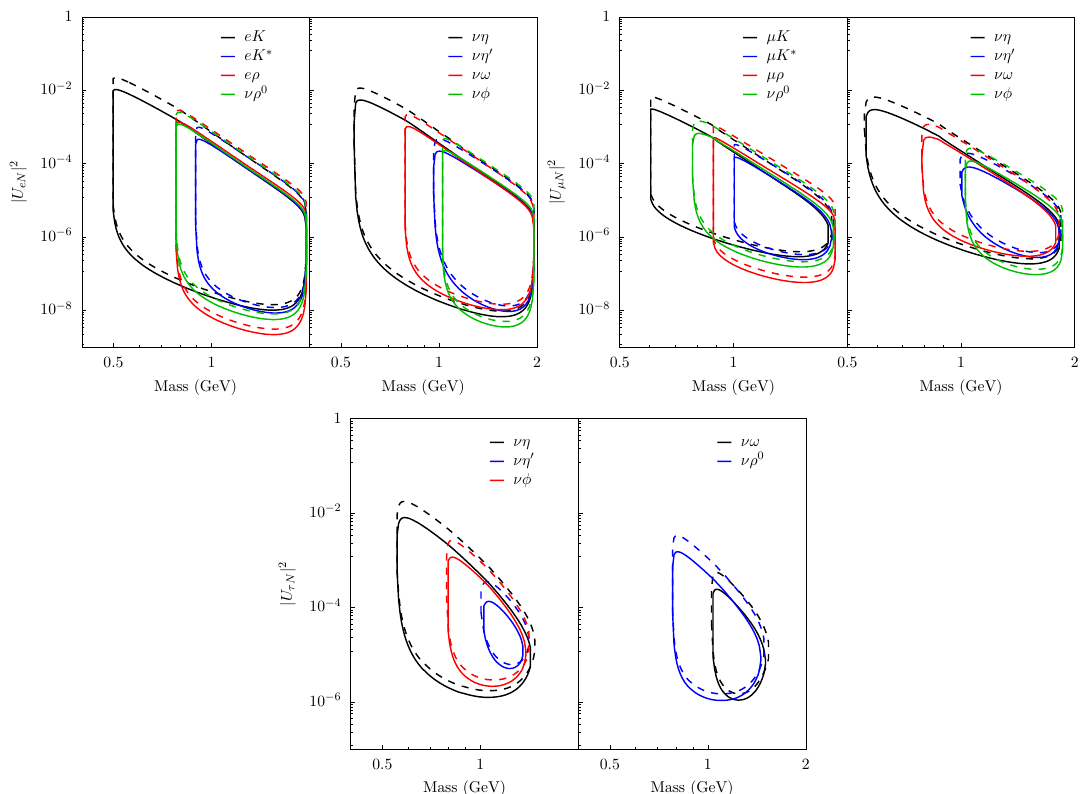
Figure 6 . The 90 % C.L. sensitivity regions to individual channels for dominant mixings j U eN j 2 (top left), j U (cid:22)N j 2 (top right), and j U (cid:22)N j 2 (bottom) are presented for Majorana (solid lines) and Dirac (dashed lines) neutrinos. No background analysis was performed for the channels shown here (see text). These channels become available only for masses above 0.5